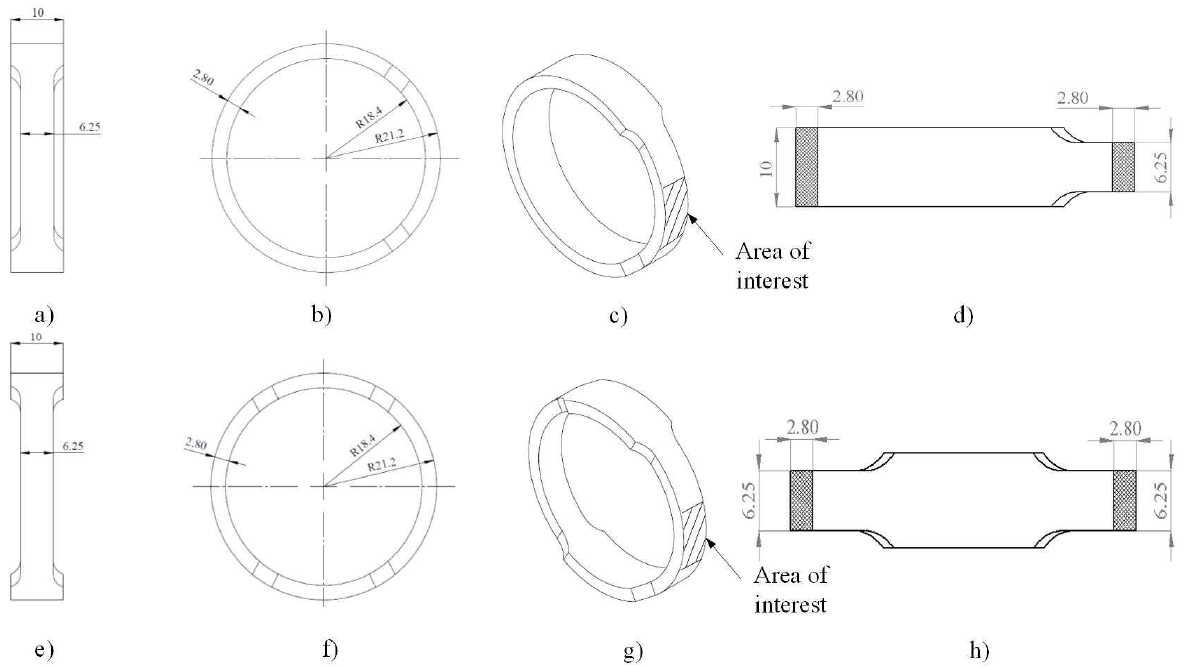
Figure 1. Pipe Ring Tensile Specimen dimensions DN32 (Ø42.4 × 2.8 mm): ( a ) front view Single PRTS; ( b ) side view Single PRTS; ( c ) isometric view Single PRTS; ( d ) nominal cross-section area Single PRTS; ( e ) front view Double PRTS; ( f ) side view Double PRTS; ( g ) Isometric view Double PRTS; ( h ) nominal cross-section area Double PRTS.